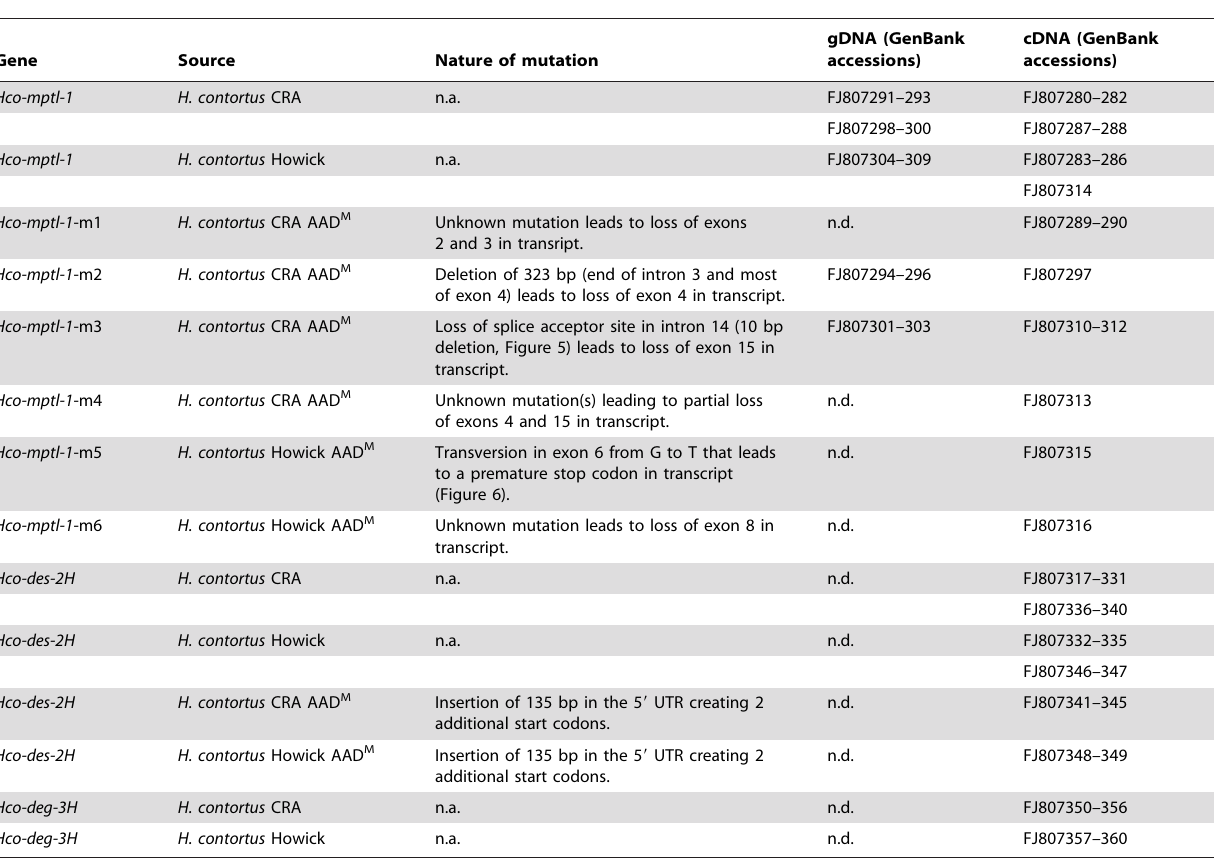
Table 2. Summary of H. contortus ACR genes and mutations occurring in the AAD mutant lines.